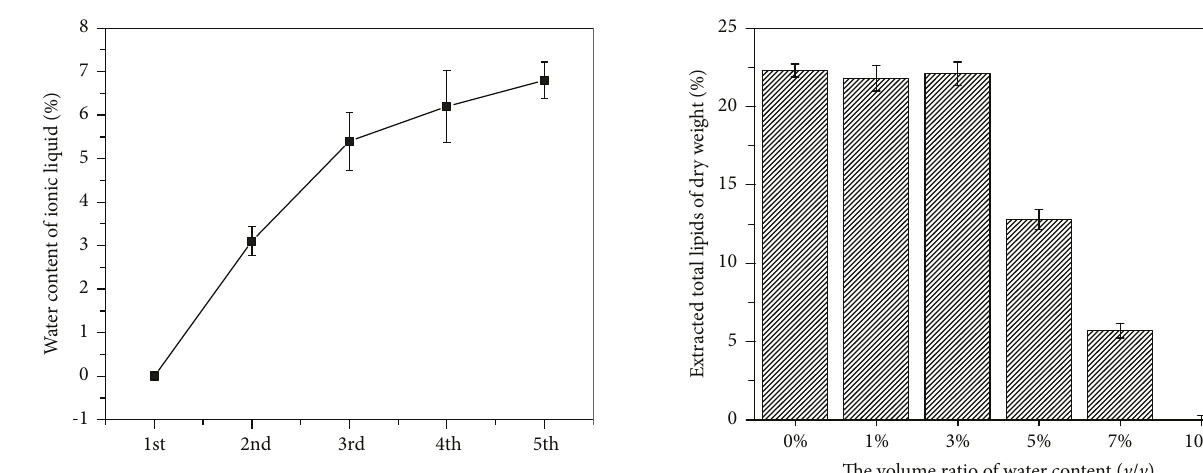
on lipid extraction and ionic liquid loss. 4